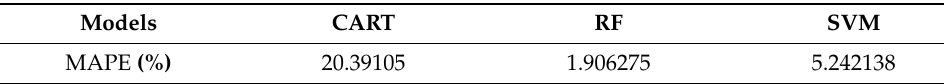
Figure 10. The negative prediction values distribution of all models. Lewis [39] claims that MAPE values of less than 10% indicate a high level of accuracy, while values of 10% to 20% indicate a reasonable level of accuracy. Thus, RF (1.906) and SVM (5.242) are a high level of accuracy. At the same time, CART (20.391) is a reasonable level of accuracy. Table 9 shows the average MAPE value of machine learning models. Table 9. Average MAPE value of machine learning models.